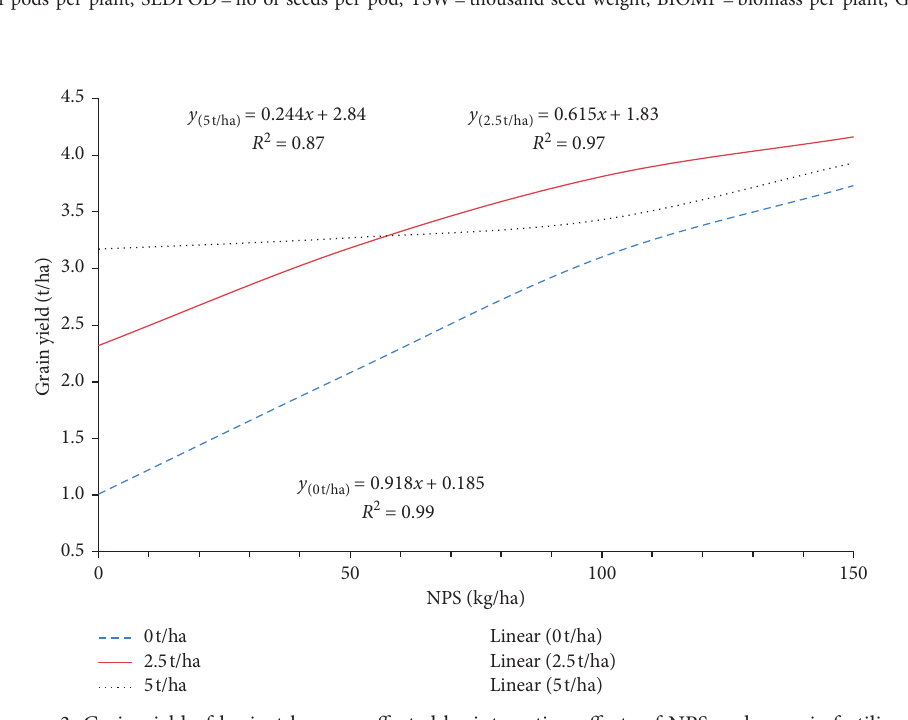
Figure 3: Grain yield of haricot bean as affected by interaction effects of NPS and organic fertilizer.